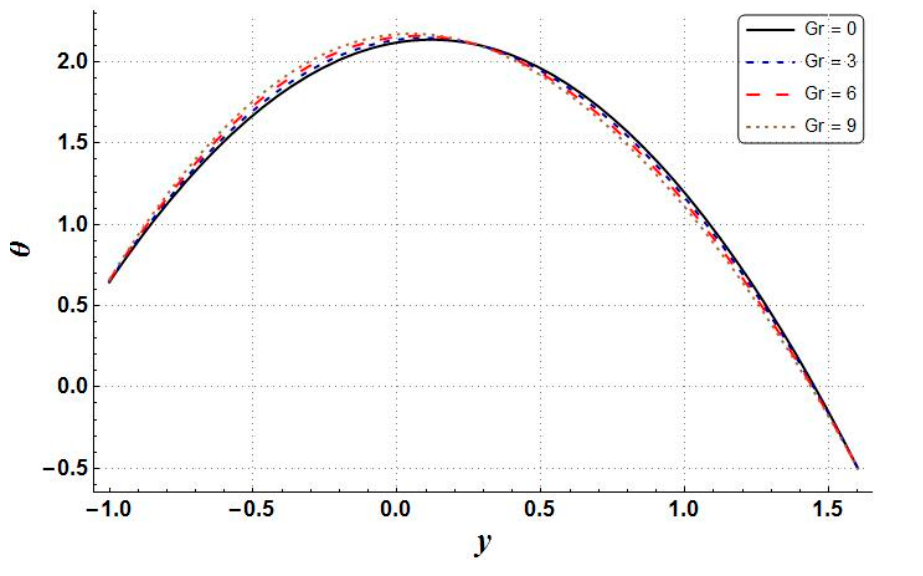
θ through changing values of